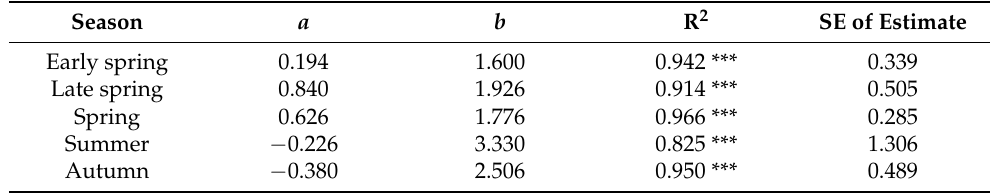
Figure 1. Weight per shoot for plants harvested under different standards in early and late spring, summer, and autumn over three experimental years (means ± standard errors, n = 4). Single bars without data points located above columns are LSD values indicative of significant ( p < 0.05) differences between harvest standards in the specified season. Table 1. Linear regression of the mean dry weight per shoot (mg) values against the numbers of young and expanding leaves ( shoot weight = a + b × leaf number , n = 16).